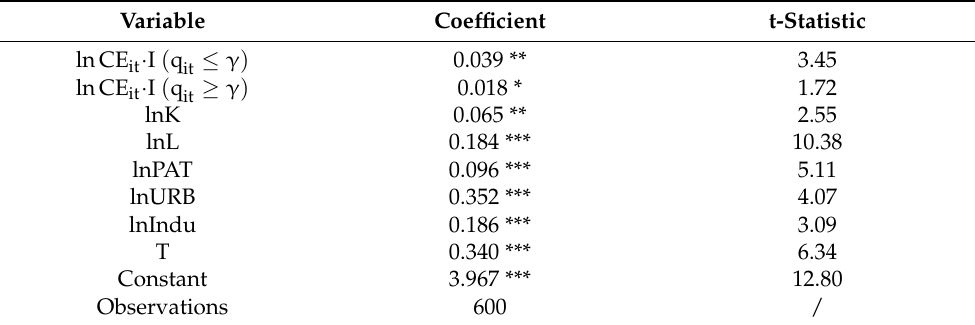
Table A1. Robustness Testing Results using EI2 as the threshold